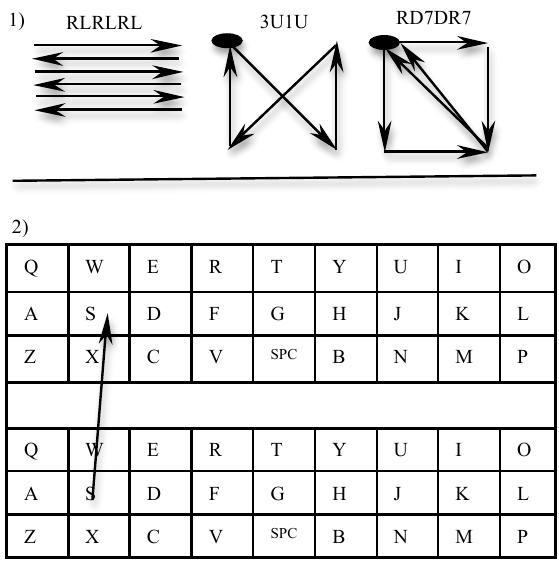
Figure 3: Gestures adapted from (H. Drewes & Schmidt, 2007) Context switching keyboard adapted from (Morimoto & Amir, 2010) S ACCADES AND D YNAMIC GDO